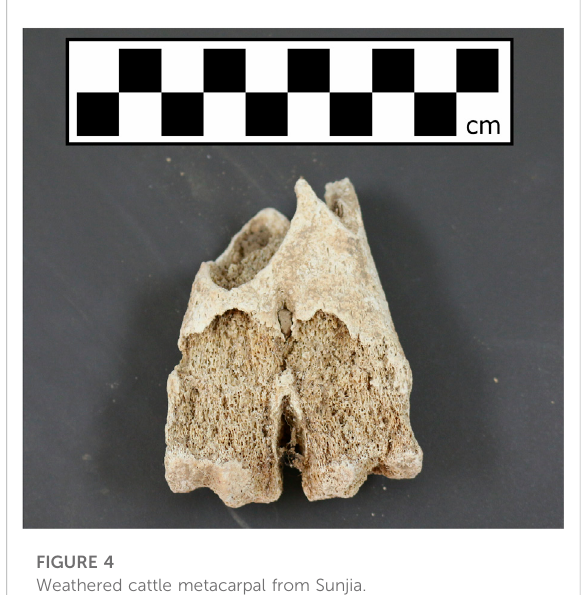
FIGURE 4 Weathered cattle metacarpal from